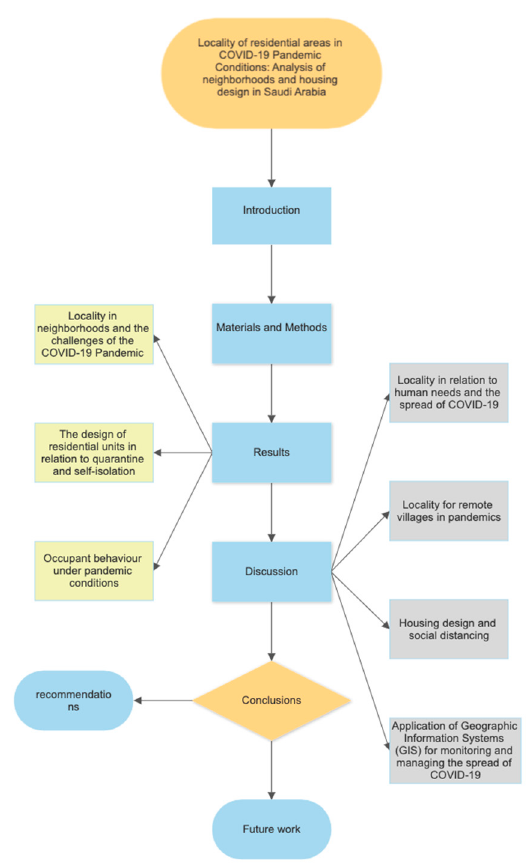
Figure 1. Flow chart for the study.